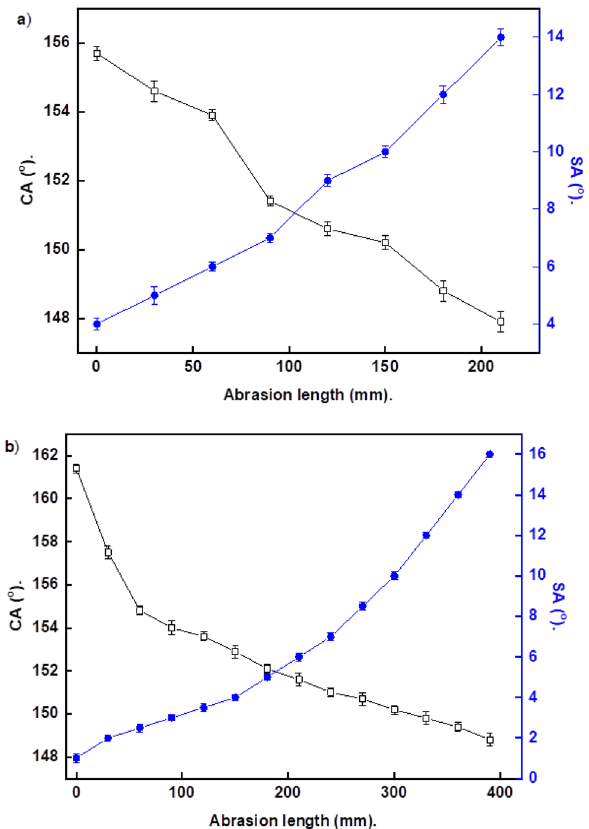
Figure 6. Variation of CAs and SAs with the abrasion length for steel coated by ( a ) Ni-SA coating and ( b ) Ni-G-SA